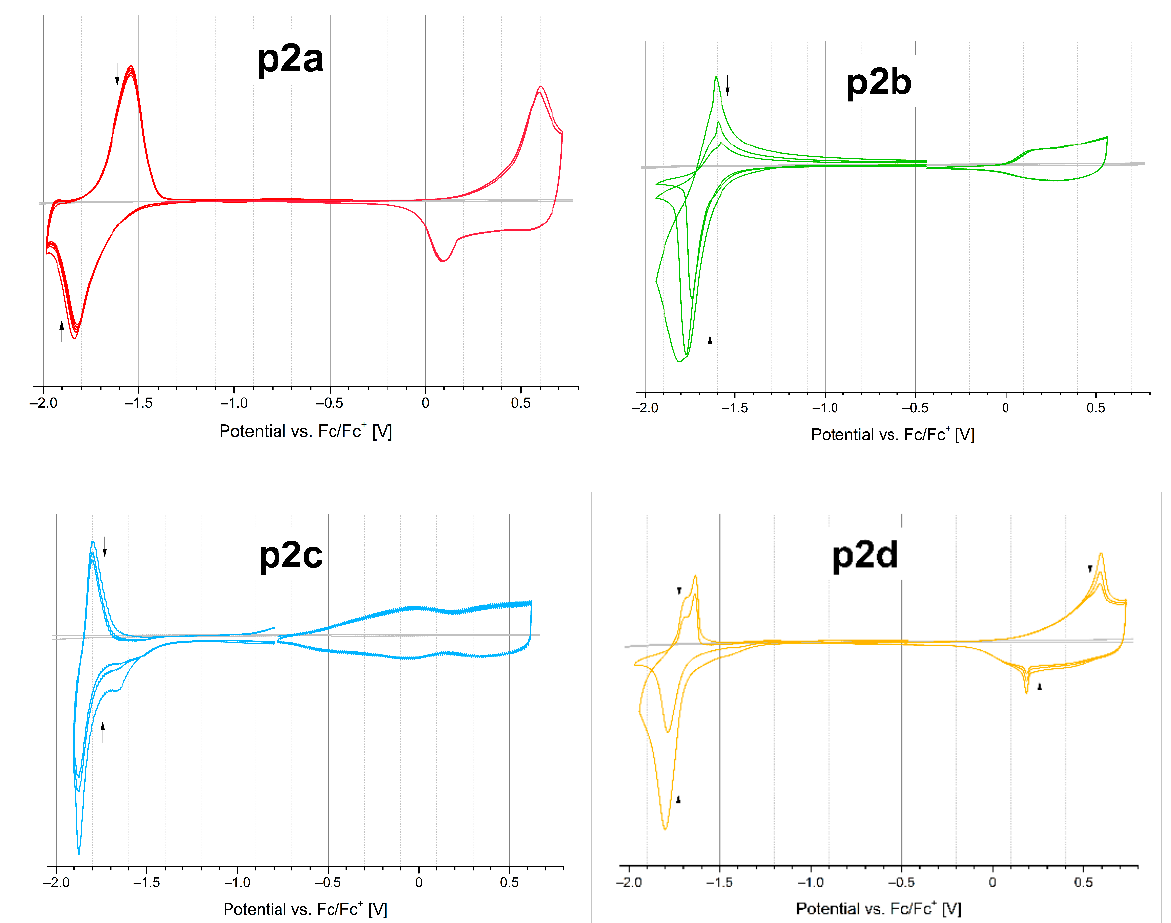
Figure 5. The CV of polymer films p2a – d on Pt wire versus ferrocene redox couple in DCM, 100 mV/s and background (gray line).